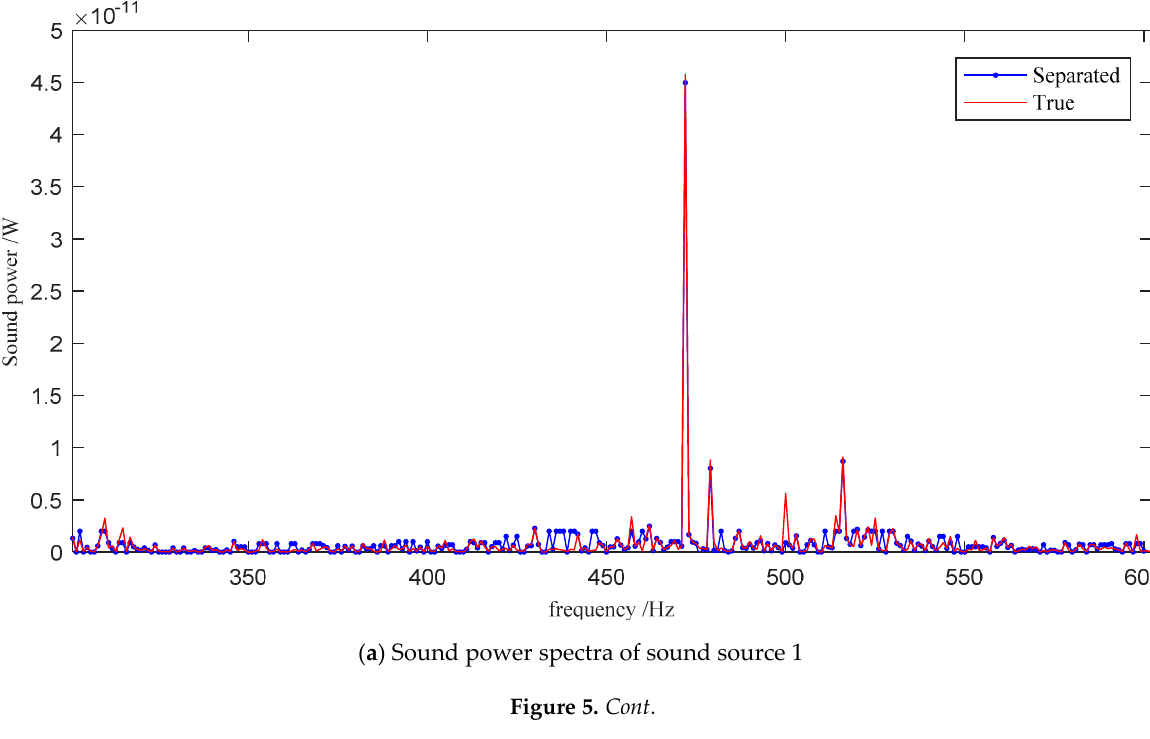
Figure 4. Sound intensity measured by the three-dimensional probe. The positions of the sound sources, the positions of the probes, and the sound intensity were substituted into Equation (10) as known quantities, and the PSO was used to solve the sound power of the nine sound sources at each frequency point. The separated spectra were compared with the true power spectra measured by the one-dimensional sound intensity probe, as shown in Figure 5.